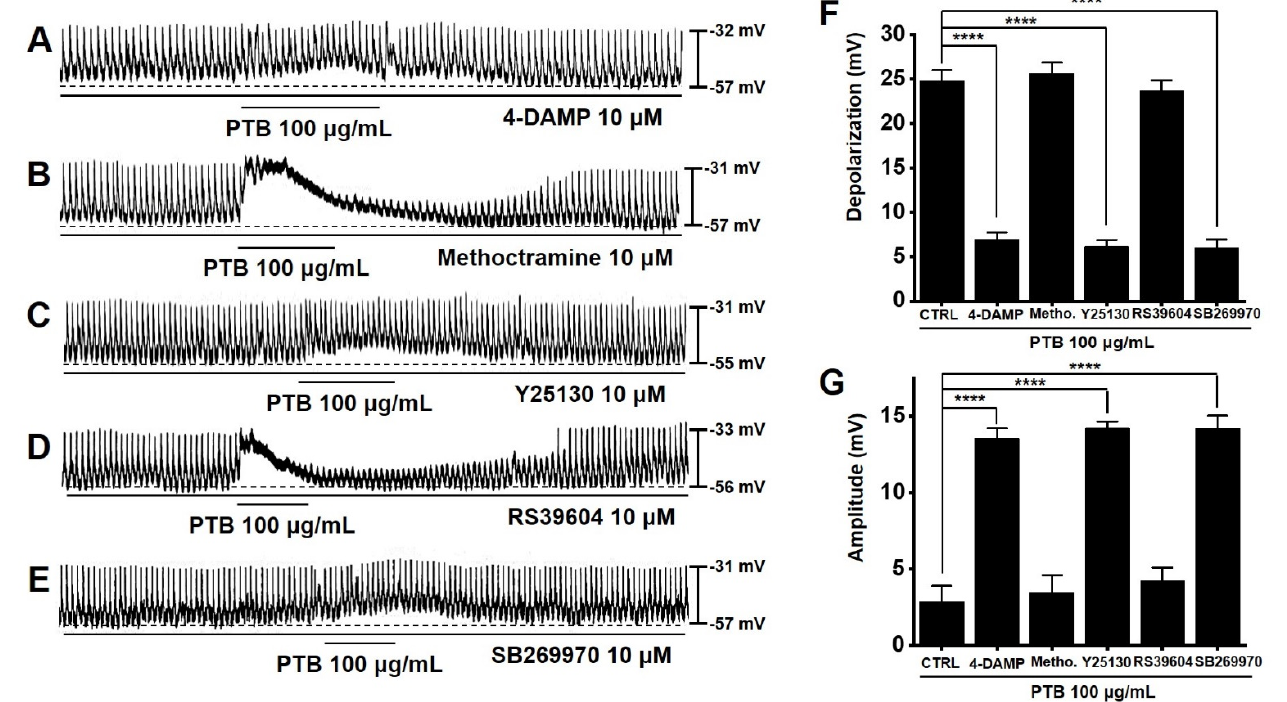
Figure 8. Effects of muscarinic and 5-HT receptor antagonists on PTB extract-induced pacemaker potential depolarization. ( A ) Pre-treatment with 4-DAMP inhibited PTB extract-induced effects. ( B ) Pre-treatment with methoctramine had no effects on PTB extract-induced effects. ( C , E ) Pre-treatment with Y25130 or SB269970 inhibited PTB extract-induced effects. ( D ) Pre-treatment with RS39604 had no effects on PTB extract-induced effects. ( F , G ) Depolarization and amplitude responses to PTB extract are summarized. Means ± SEs. **** p < 0.0001. PTB: Pinellia ternate Breitenbach. CTRL: control. Metho.: methoctramine.